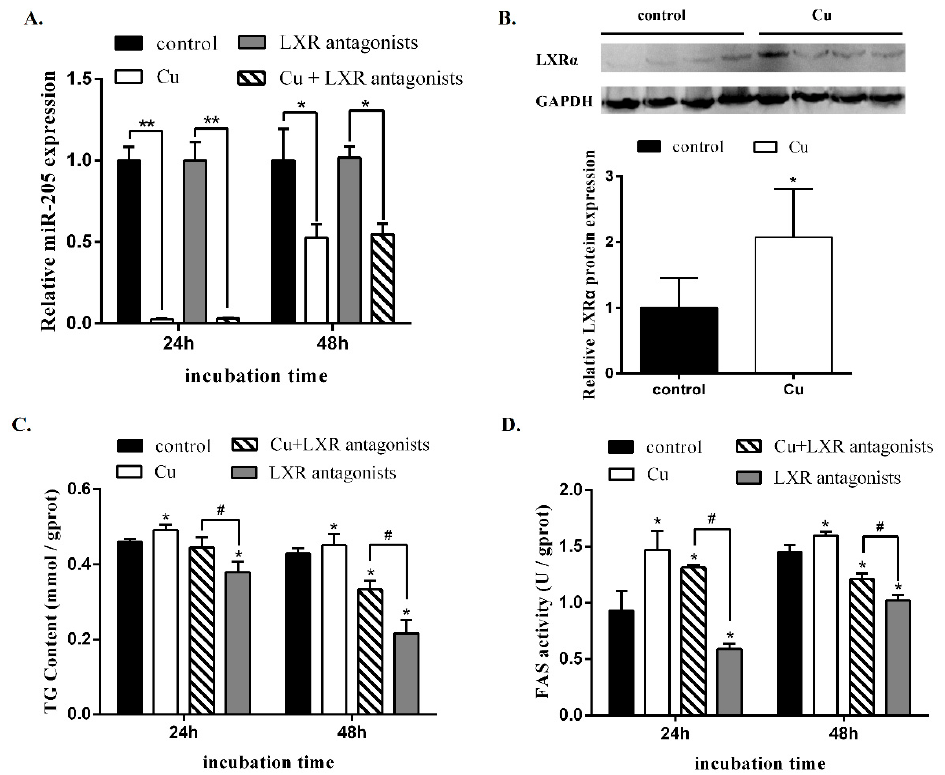
Figure 8. Effects of different treatment for 24 and 48 h on miR-205 expression, LXR α protein expression and FAS activity, and TG content in hepatocytes from yellow catfish. ( A ) Cu exposure inhibited miR-205 expression in vitro at 24 and 48 h. Mean of the results from the control was set as 1. Values are mean ± SEM ( n = 3). miR-205 expression values were normalized to U6 expressed as a ratio of the control at 24 and 48h. * p < 0.05; ** p < 0.01; NS: Student’s t test. The experiment was repeated at least three times. ( B ) Cu incubation increased LXR α protein expression. LXR α protein expression level was increased with Cu incubation in vitro at 24 h, based on the image J analysis. Mean of the results from the control was set as 1. Values are mean ± SEM ( n = 4). LXR α protein expression values were normalized to GAPDH protein expressed as a ratio of the control at 24h. ( C , D ) Change of FAS activity and TG content after miR-205 was inhibited by Cu and lxr α inhibited by LXR antagonist at 24 and 48h. Mean ± SEM ( n = 3 independent biological experiments). * p < 0.05, compared with control. # p < 0.05, compared with single LXR antagonist incubation (independent-samples t -test).